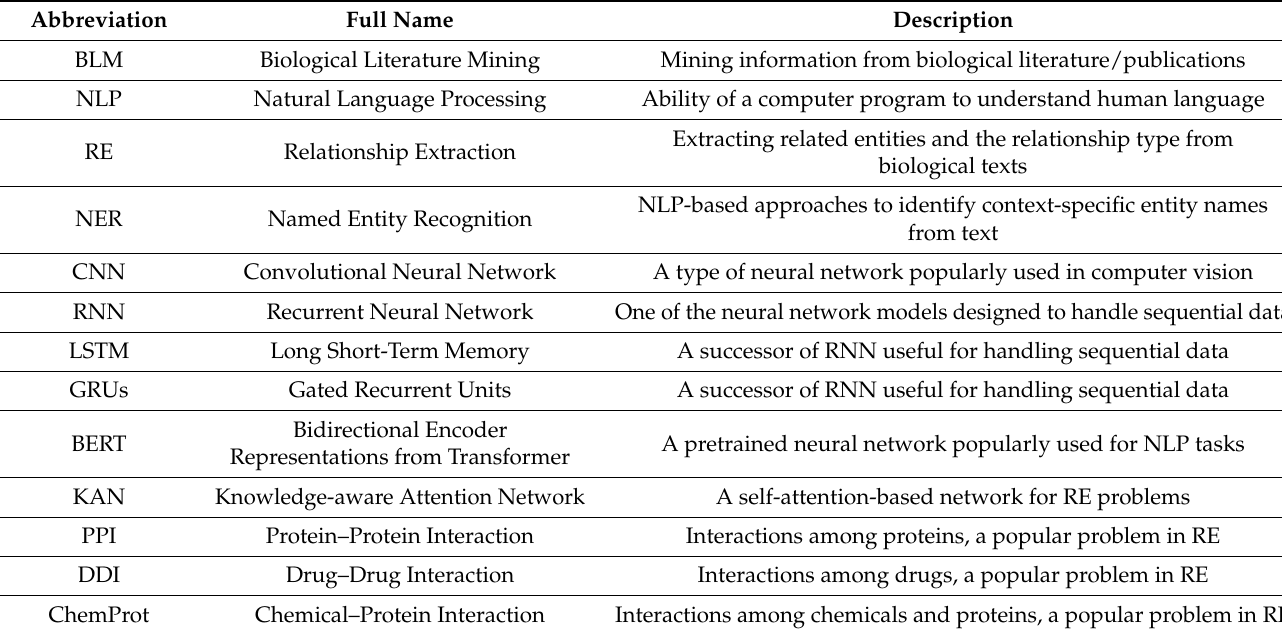
Table 1. Key abbreviations for text mining. Rows with text mining problem names are marked in blue; model names are marked in red; biological interaction database names are marked in